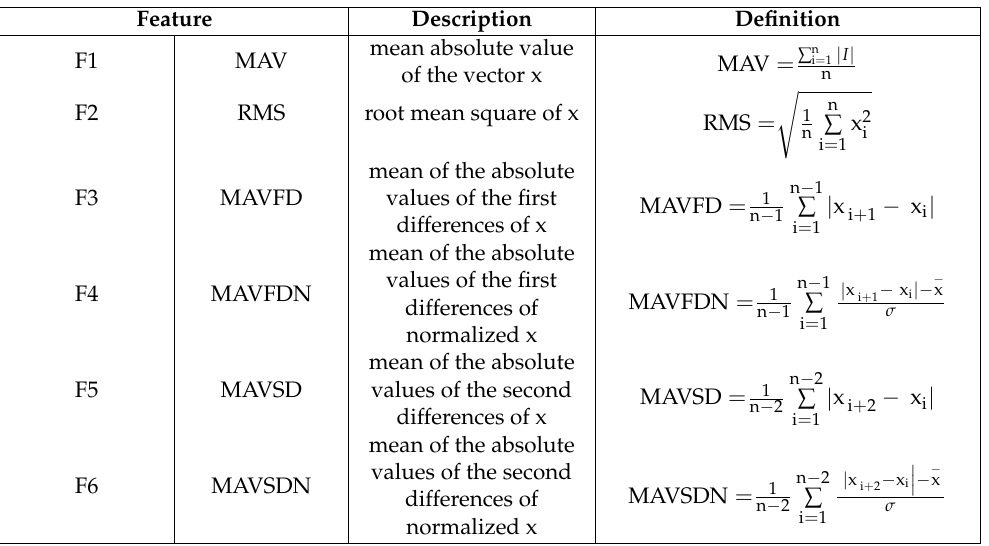
Table 2. Feature description and definition.